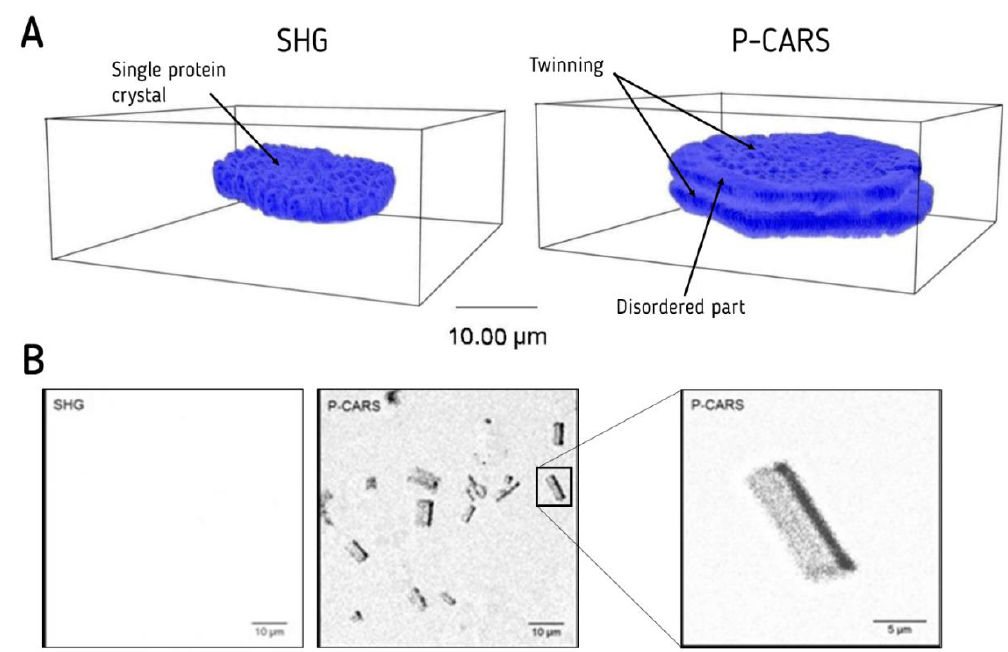
Figure 4. Comparison of second harmonic generation (SHG) and polarized coherent anti-Stokes Raman scattering (P-CARS) ( A ) detection of hexagonal bacteriorhodopsin crystal with twinning and contouring disordered part. ( B ) lysozyme microcrystals. Panels A and B were redrawn from Figure 2 and Figure S9 [147], respectively with permission from ACS